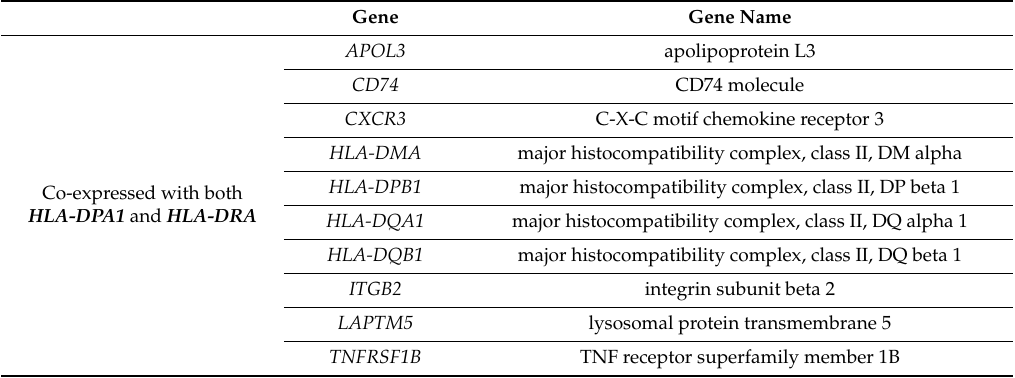
Figure 6. The Venn diagram analysis on the left panel showed 14 HLA-DPA1 co-expressed genes in cutaneous melanoma from three datasets of clinical cutaneous melanoma specimens. The Venn diagram analysis on the right panel showed 13 HLA-DRA co-expressed genes in cutaneous melanoma from three datasets of cutaneous melanoma specimens. Table 5. Co-expressed genes of HLA-DPA1 and / or HLA-DRA with the cut-o ff for selection defined as an appearance in three cutaneous melanoma